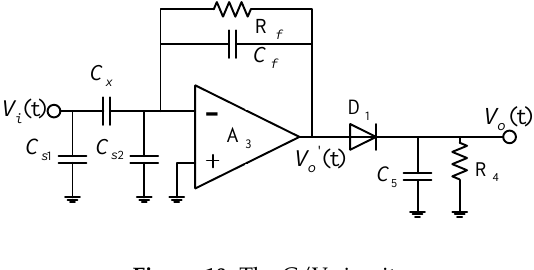
Figure 11. Input-output curve of the C/V circuit.